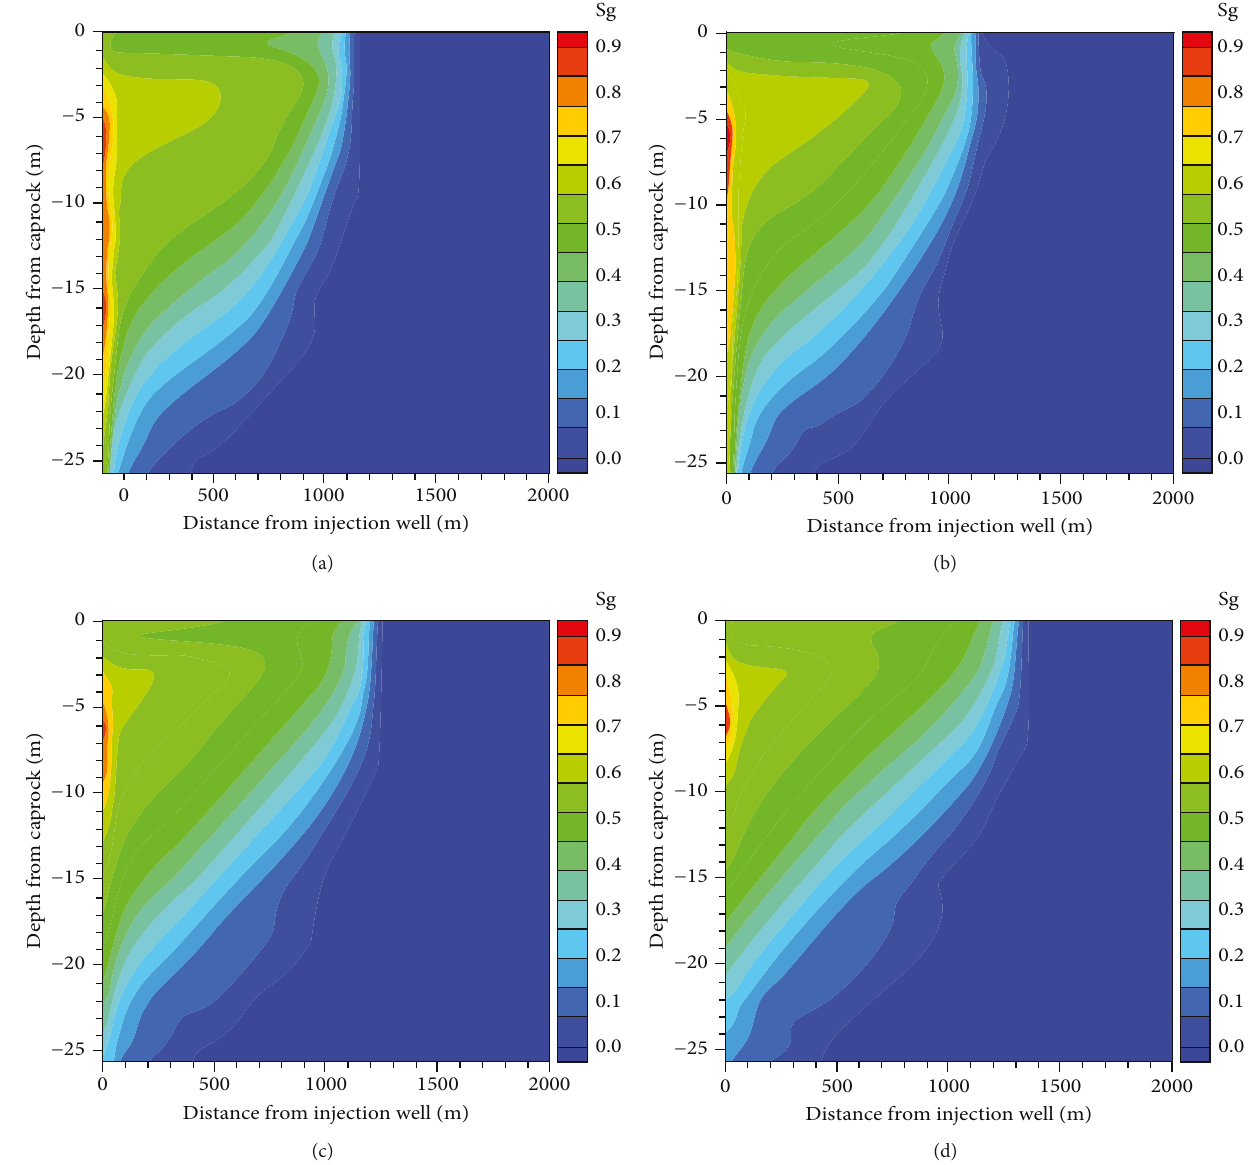
Figure 15: Spatial distributions of supercritical CO